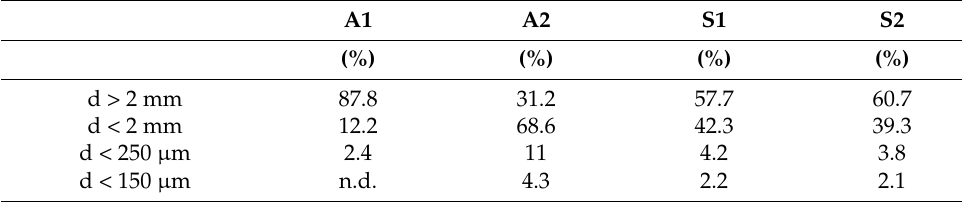
Table 1. Particle size fractions of the soil samples collected in the firing range. A1 A2